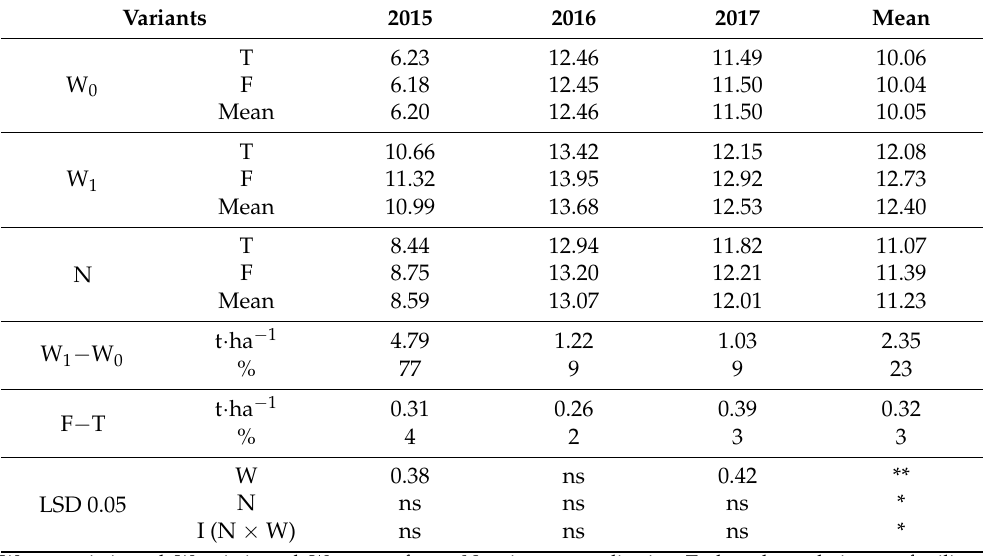
Table 3. Differentiation of dry matter yield of maize grain under the influence of experimental factors (t · ha − 1 ).